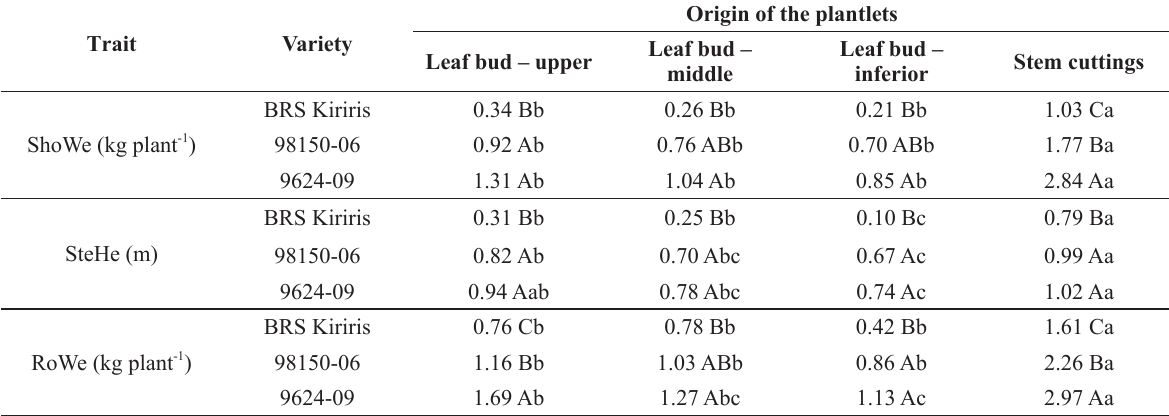
Decomposition of the interaction between cassava varieties (BRS Kiriris, 98150-06 and 9624-09) and the origin of the plantlets (from stem cuttings or leaf buds extracted from the upper, middle or inferior position of the mother plants) for three agronomic